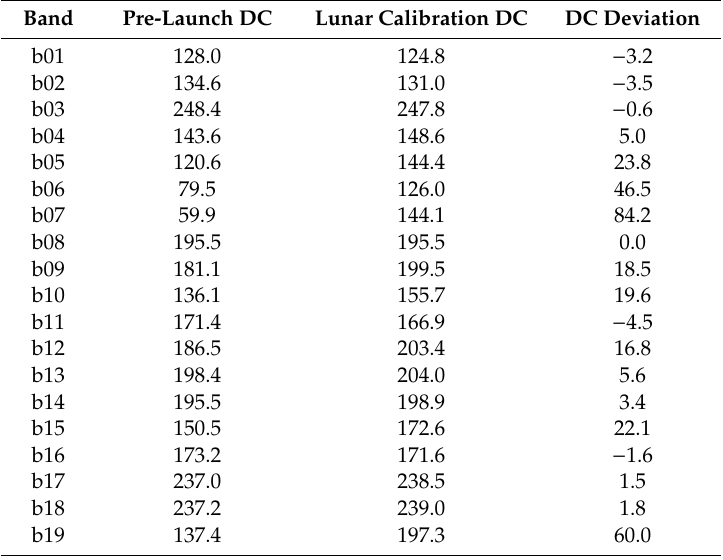
Table 3. Dark current (DC) values based on lunar calibration and prelaunch laboratory